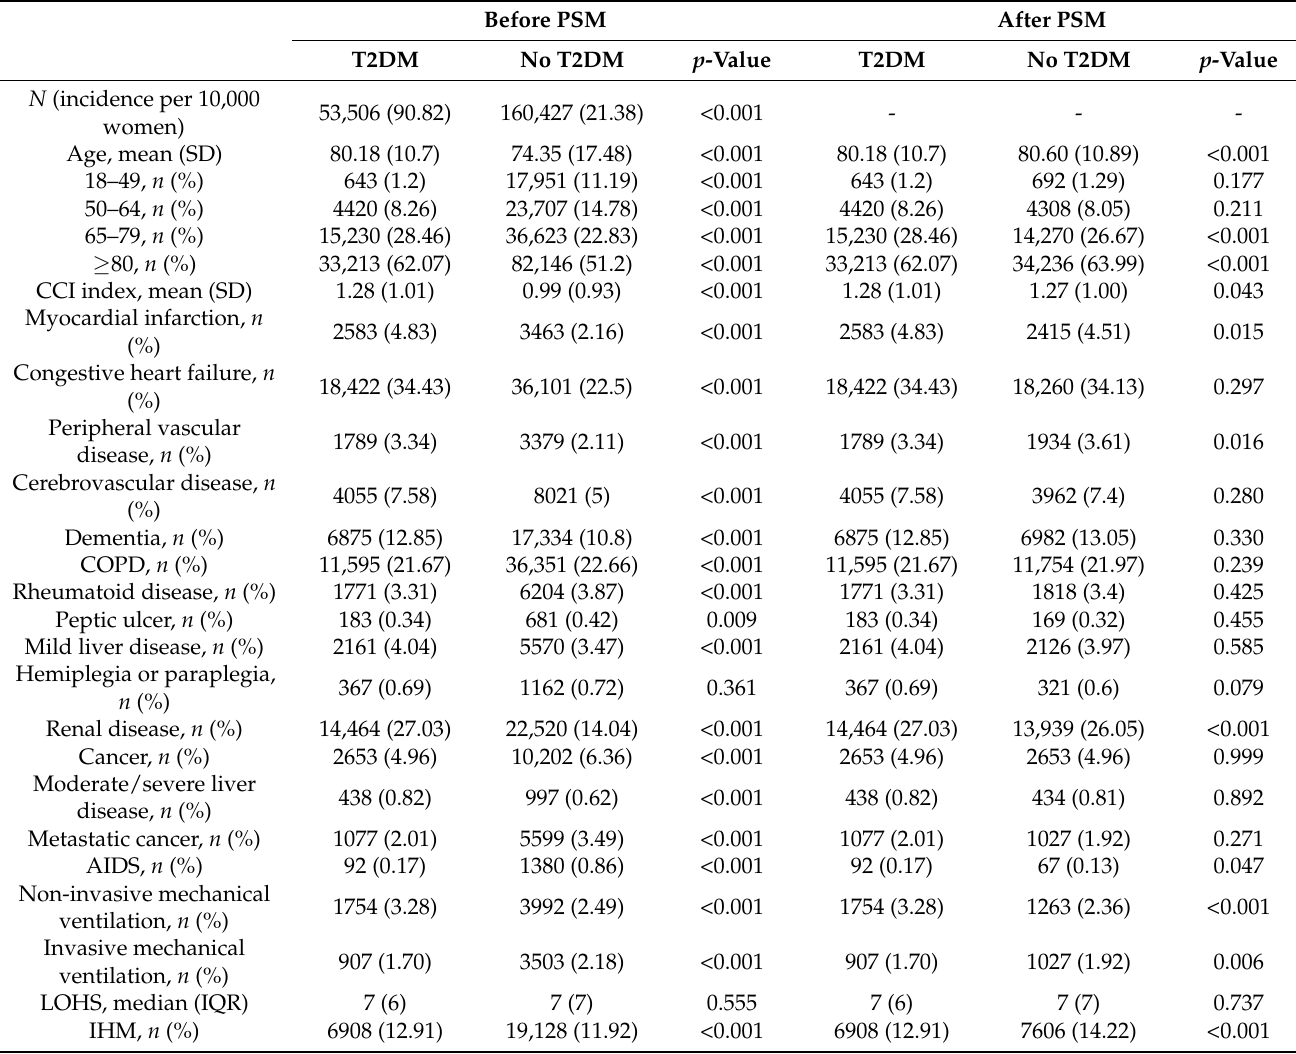
Table 2. Distribution of study covariates and hospital outcomes of women with and without T2DM hospitalized with community-acquired pneumonia (CAP) in Spain (2016–2019), before and after propensity score matching